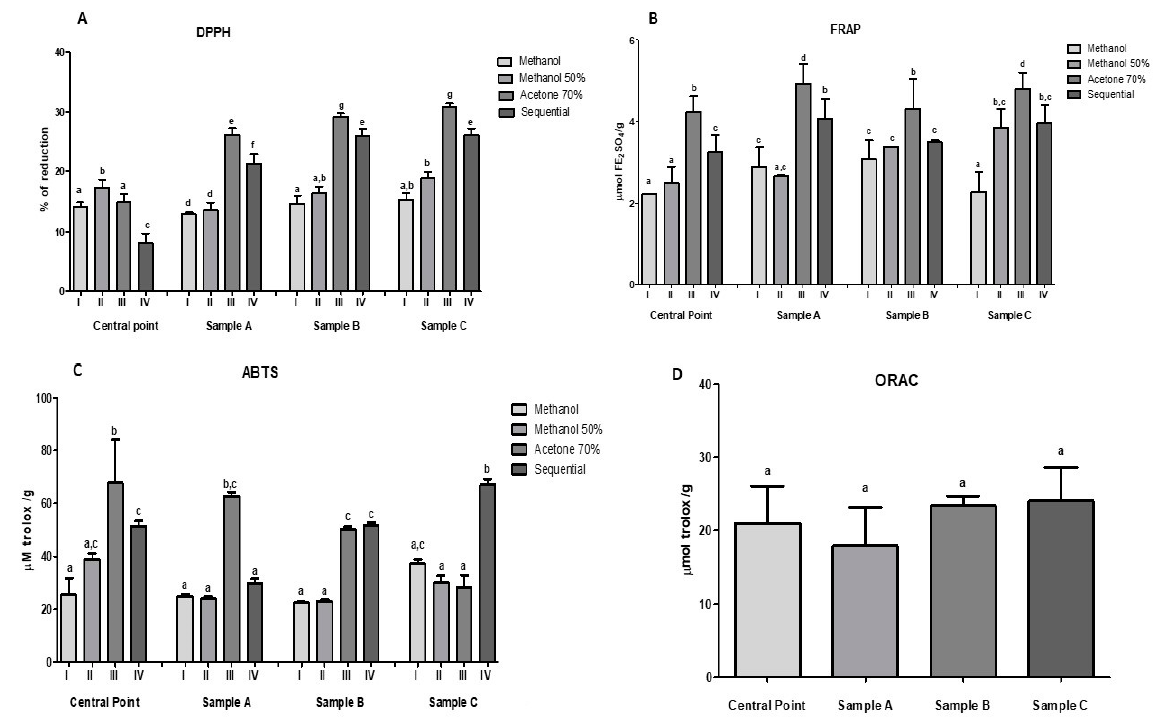
Figure 2. Antioxidant capacity of the optimized formulas and central point. ( A ) DPPH method, ( B ) FRAP Method, ( C ) ABTS Method and ( D ) Oxygen Radical Absorbance Capacity (ORAC) Test. Different letters indicate significant difference ( p <